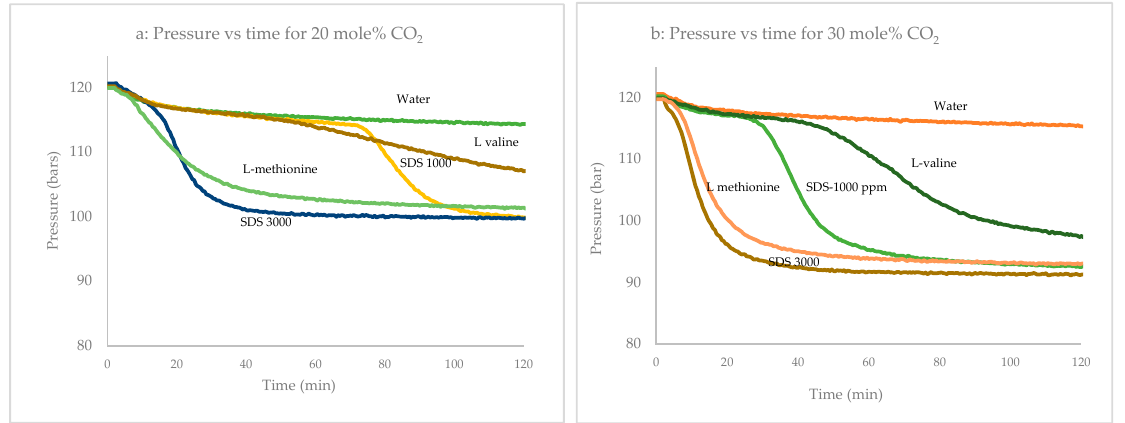
Figure 7. Pressure vs. time variation surfactant and amino acid at isothermal temp 1 °C. ( a ) Pressure vs. time curve surfactant (SDS 3000 ppm and SDS 1000 ppm) and amino acid (L-valine and L-methionine) for 20 mole% CO 2 at pressure 120 bar and 1 °C. ( b ) Pressure vs time curve surfactant (SDS 3000 ppm and SDS 1000 ppm) and amino acid (L-valine and L-methionine) for 30 mole% CO 2 at pressure 120 bar and 1 °C.